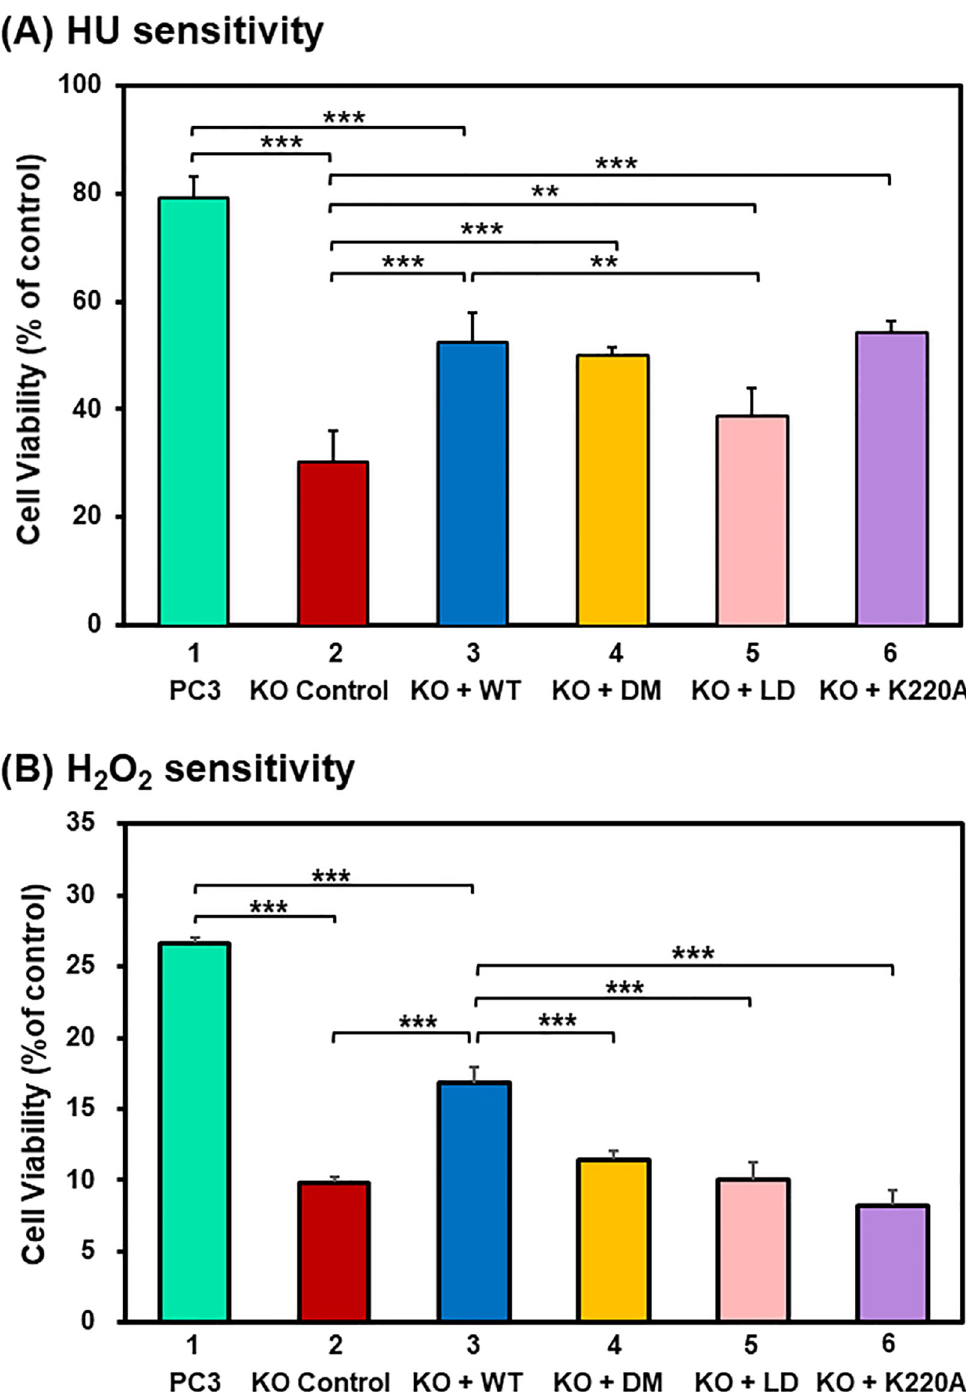
Fig 5. Cellular sensitivities to hydroxyurea (HU) and H 2 O 2 of PC3 rad9A +/+ and rad9A -/- cells expressing WT-Rad9A or mutant Rad9A. ( A ) Cell viability in response to hydroxyurea (HU). rad9A KO PC3 cells were transfected with vector p3XFLAG-CMV-14 (KO control) or vector containing hRad9A cDNA [(FLAG-WT-hRad9A, KO + WT), (FLAG-DM-Rad9A, KO + DM), (FLAG-LD-Rad9A, KO + LD) or (FLAG-K220A-Rad9A, KO + K220A)]. Plated cells were treated with 2 mM HU for 2 h or left untreated (control). After recovery for 72 hrs, the plates were incubated for 2 h in regular medium containing 40 μ g/ml of neutral red and analyzed for cell viability. ( B ) Cell viability in response to H 2 O 2 . The procedures are like ( A ) except those cells were treated with 80 μ M H 2 O 2 for 1 hr. The percentages (%) of control are the